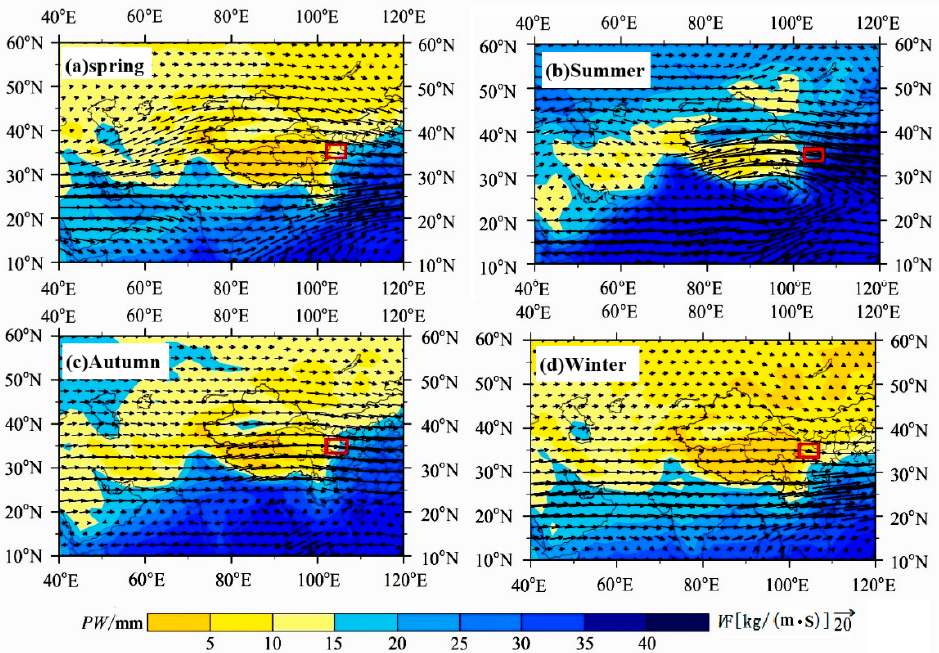
Figure 4. Monthly mean precipitable water ( PW ) and vapor flux ( VF ) from the surface to 300 hPa in the study area and its surrounding areas in spring, summer, autumn, and winter based on National Centers for Environmental Prediction/National Center for Atmospheric Research (NCEP/NCAR) Reanalysis 1. The study region is marked in a red frame.